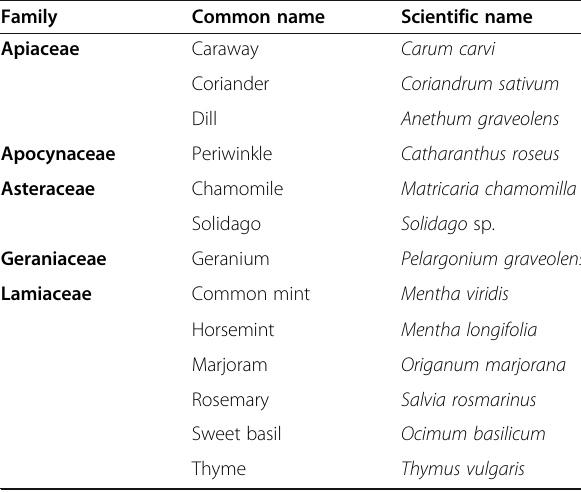
Table 1 The tested medicinal plants against